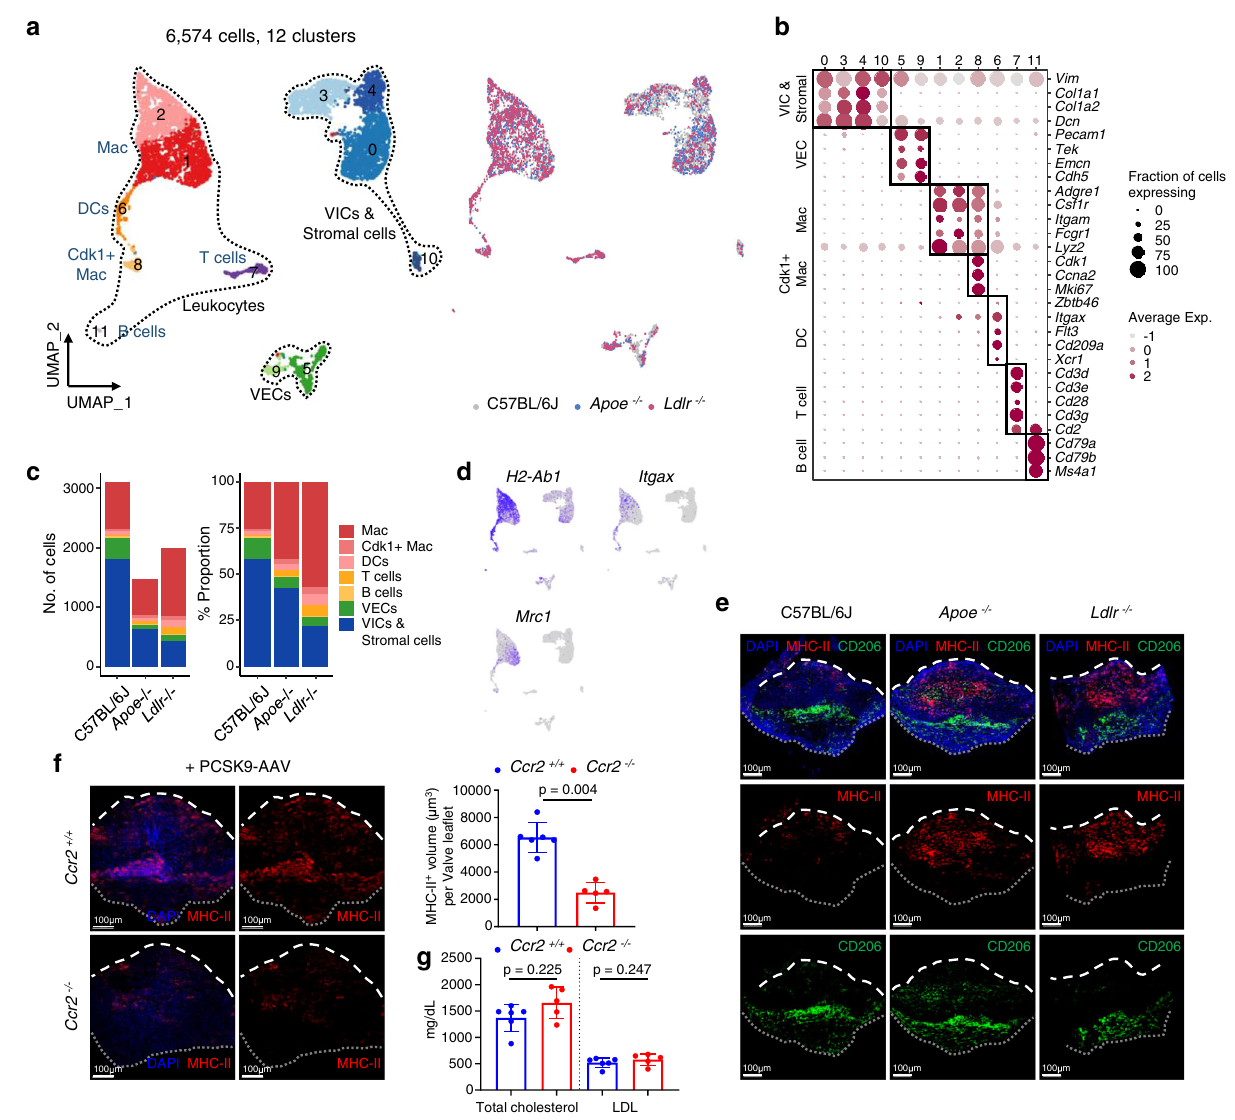
Fig. 3 | Comprehensive single-cell pro fi ling reveals that monocyte-derived macrophages are the major immune cells accumulated in aortic valve during hyperlipidemia.a Uniformmanifoldapproximationandprojection(UMAP)plotof 6574singlecellscoloredbytheclusters(left)andmousemodels(right). Apoe − / − and Ldlr − / − mice were fed a WD for 16 weeks. b Average expression map of known cell- typemarkergenesforeachcellcluster.Colorrepresentsaverageexpressionlevels, whicharescaledbyz-transformationandlimitedtoascalefrom − 2.5to2.5.Dotsize represents the fraction of cells with the expression value of each marker gene for each cluster. c Absolute cell number (left) and relative proportion (right) of the majorcelllineagesfromeachmousemodel. d UMAPplotofgeneexpressionof H2- Ab1 , Itgax , and Mrc1 (gray to blue). e Whole-mount immunostaining of the aortic